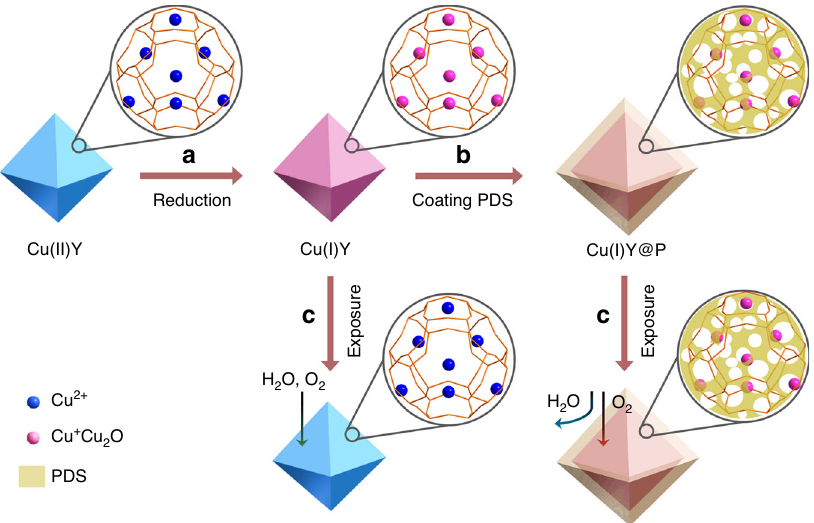
Fig. 1 Construct superhydrophobic microenvironment and enhance Cu(I) oxidation resistance. a Selective reduction of Cu(II)Y to Cu(I)Y; b Creation of superhydrophobic surface via coating PDS on Cu(I)Y; c Enhancement of oxidation resistance of Cu(I) after PDS coating upon exposure to humid atmosphere. The access of moisture to Cu(I) sites is excluded by superhydrophobic surface, and oxidation is hindered despite the presence of